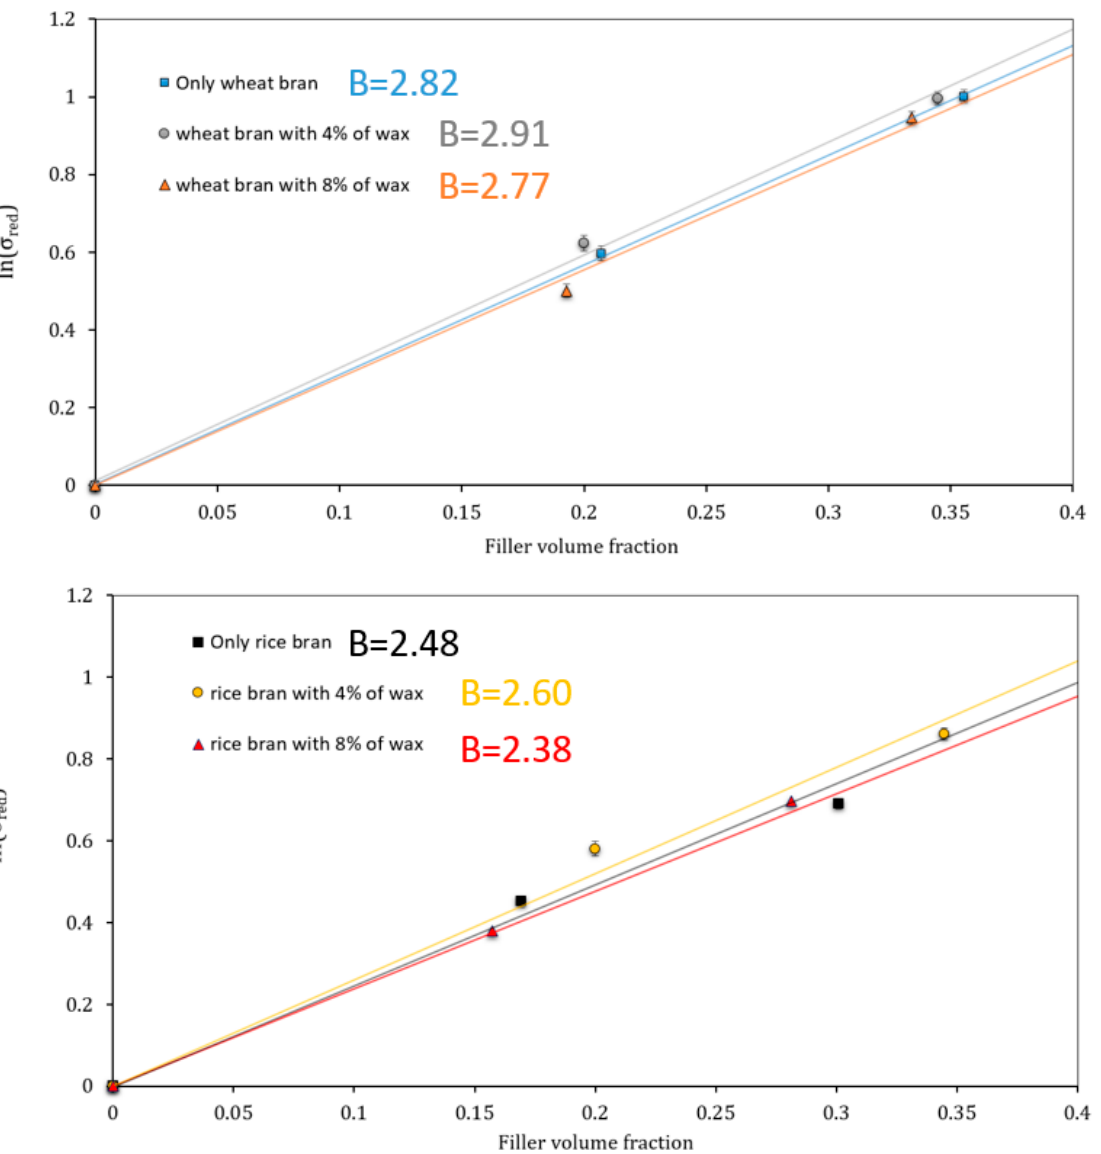
Figure 6. Pukanszky’s analytical model application that demonstrates the better adhesion ma- trix/filler with a 4% wax treatment.